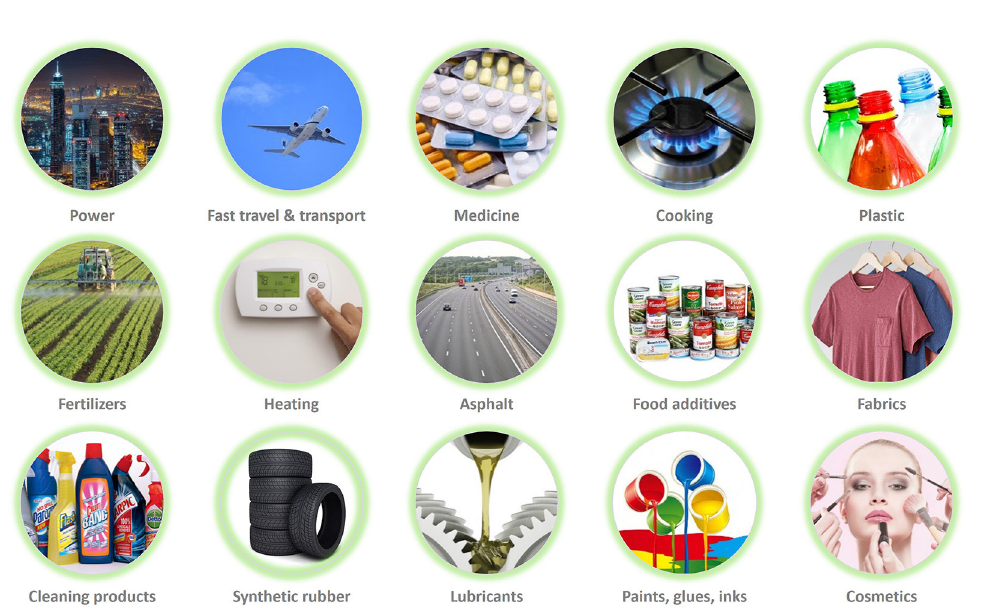
Fig. 17. – Benefits and uses of oil and gas. Natural hydrocarbons and their derivatives are central to modern life today. In many demand sectors there are no viable substitutes